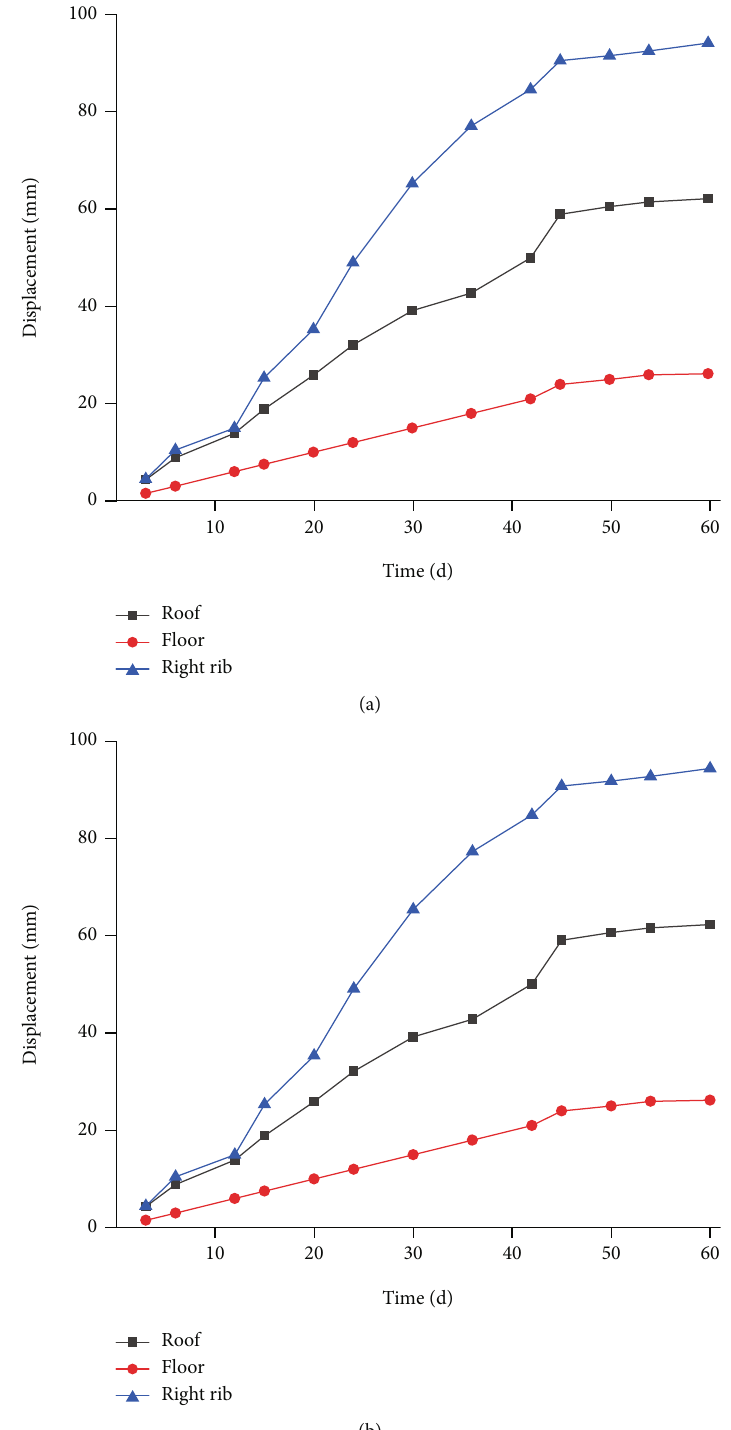
Figure 16: Surface displacement curve of roadway. (a) Before the optimization. (b) After the